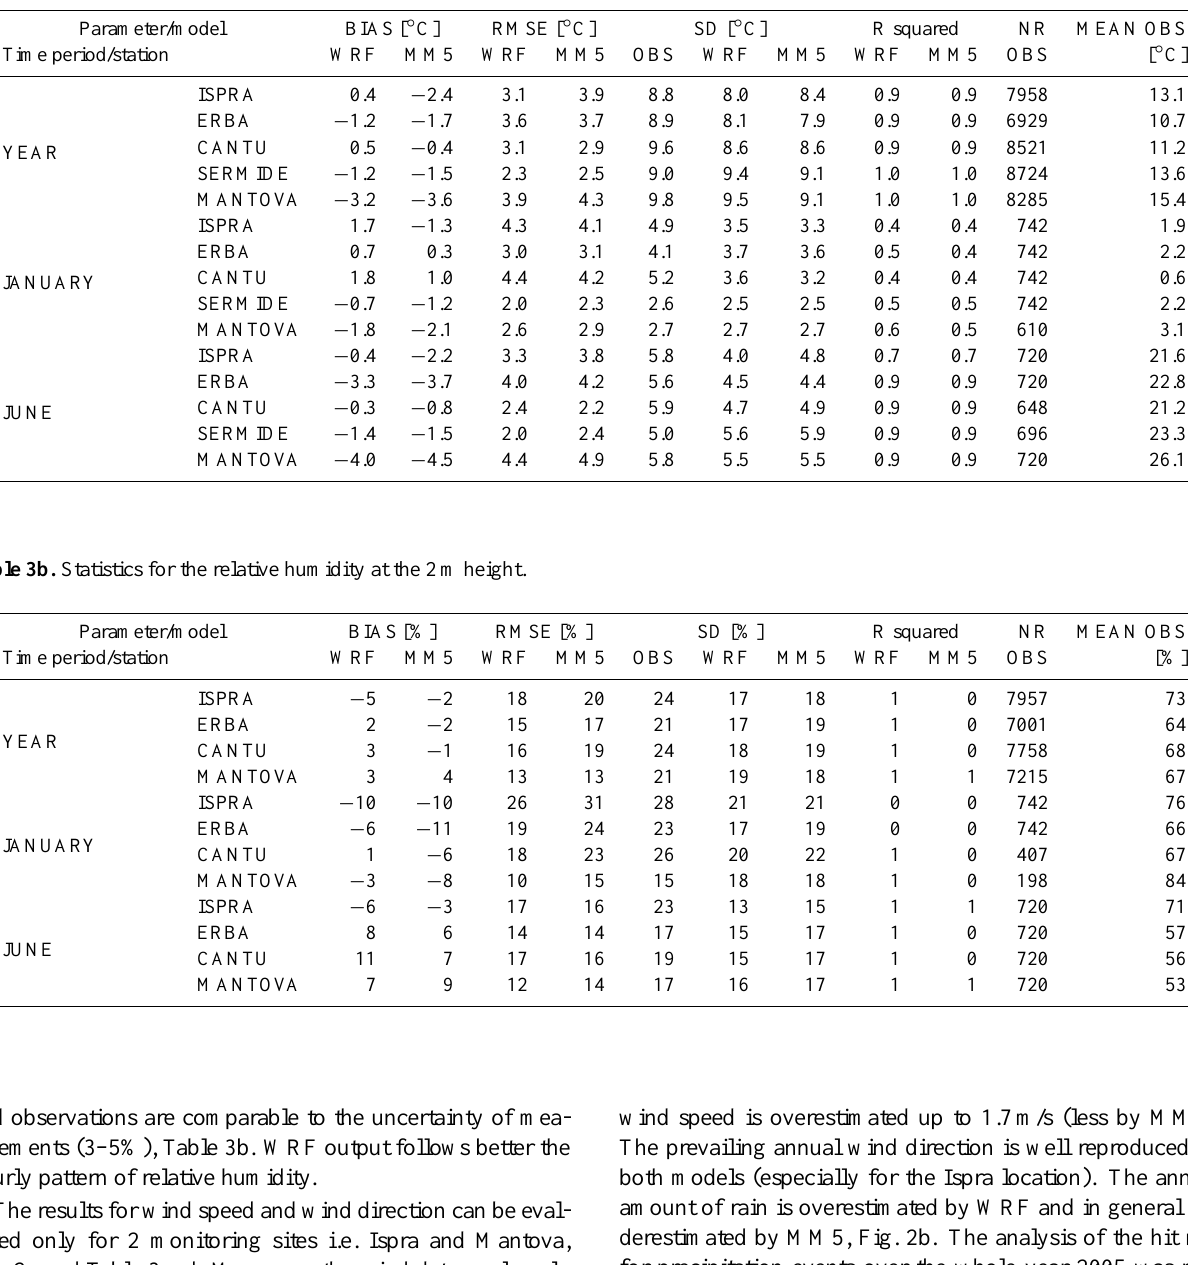
Table 3a. Statistics for the temperature at the 2m height.